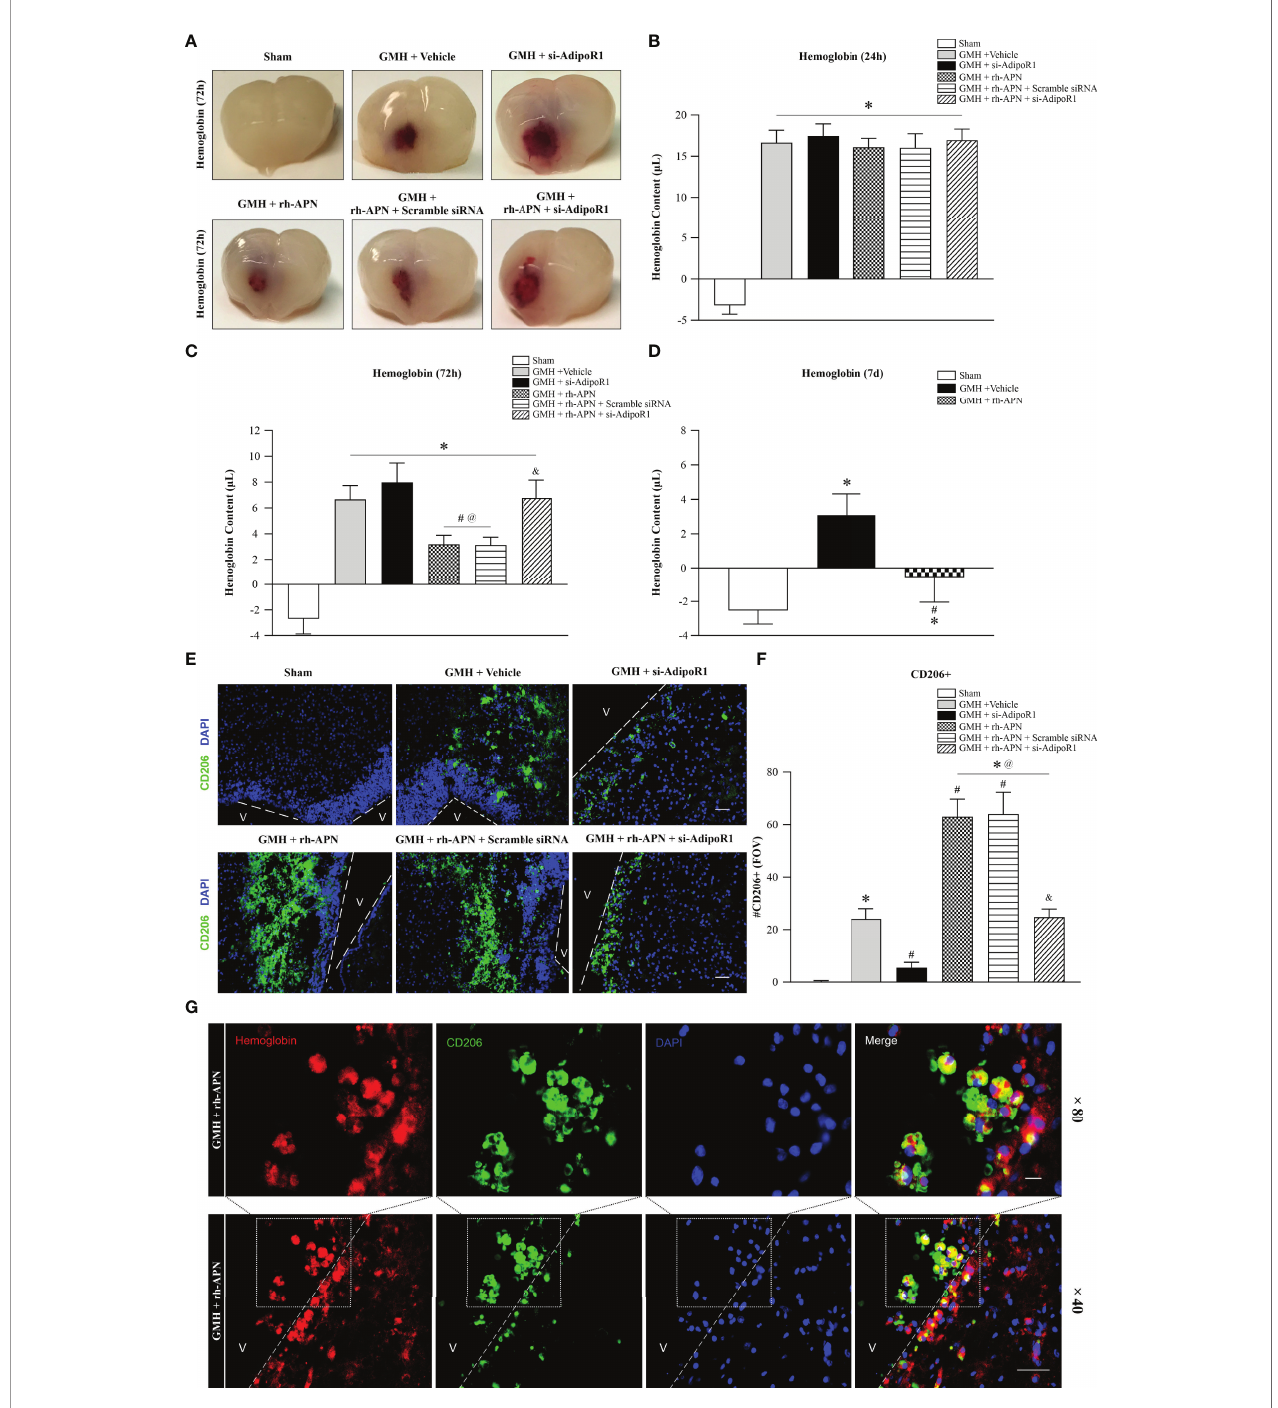
FIGURE 6 | rh-APN promoted hematoma clearance by increasing M2 microglia in the periventricular area after GMH. (A) Representative images of hematoma in the periventricular area of brain at 72 h after GMH. (B – D) Hemoglobin assays were conducted at (B) 24 h, (C) 72 h, and (D) 7 d. (E) Representative images of immuno fl uorescence staining and (F) quanti fi cation showing the accumulation of M2 microglia in the periventricular regions after GMH. Scale bar = 50 m m. n = 6 for each group. Values are expressed as mean ± SD. ANOVA, Dunnett. n = 6 for each group. * P < 0.05 compared to sham, # P < 0.05 compared to GMH + Vehicle, @ P < 0.05 compared to GMH + si-AdipoR1, & P < 0.05 compared to GMH + rh-APN or GMH + rh-APN + Scramble siRNA. (G) Representative images of immuno fl uorescence staining showing co-localization of CD206 with hemoglobin in periventricular area after GMH with rh-APN treatment. Scale bar = 50 m m, Upper panel; Scale bar = 50 m m, lower